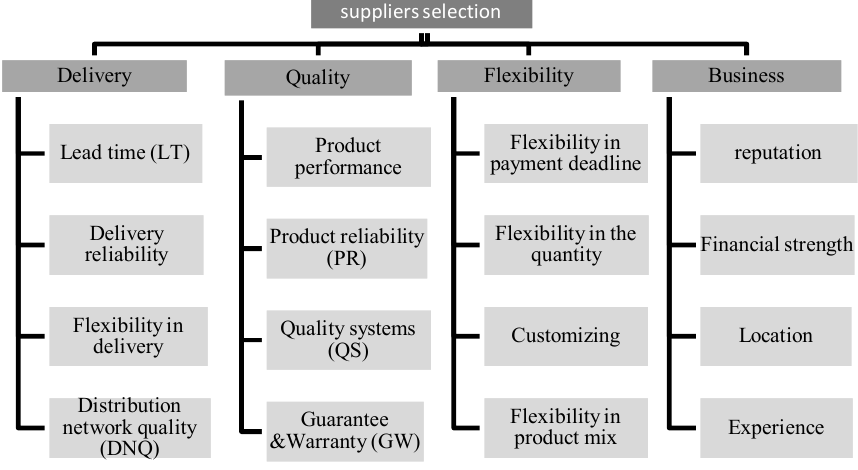
Fig. 1. Supplier Section